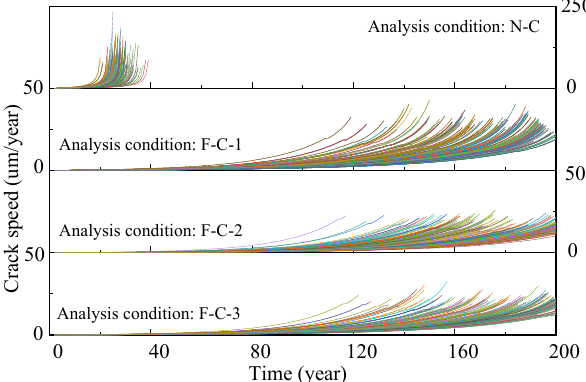
Figure 16. Crack speed of wire samples (suspender No. 26).